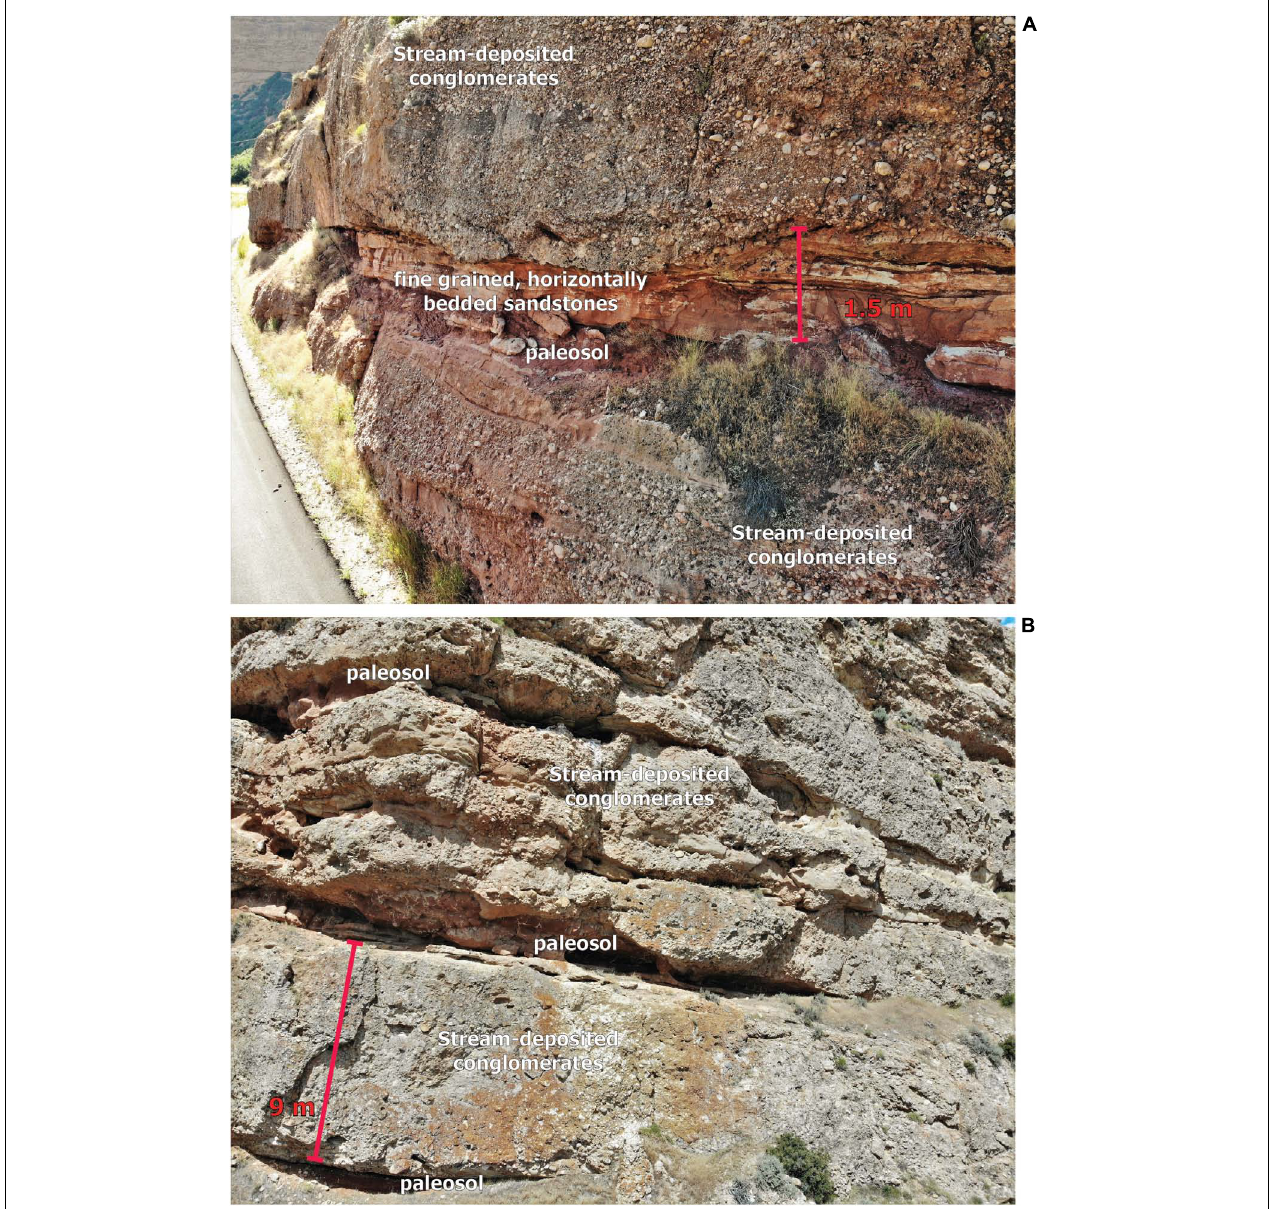
FIGURE 5 | Representative outcrops showing common facies associations in study areas. Coarse-grained conglomeratic units representing channel deposits are usually capped by paleosol horizons, which are in turn scoured into by overlying conglomerates. (A) The Echo Canyon Conglomerate. Shown in this image are clast-supported, cobble conglomerates above and below a relatively fine-grained interval containing paleosols and thin-bedded sandstones. While these conglomerates are interpreted as having been deposited by streamflow due to imbrication and trough-cross-stratification, structureless clast-supported conglomerates are quite common in the Echo Canyon Conglomerate and are interpreted as debris-flow deposits. Clast- to matrix- supported very angular conglomerates are rare (but present) and are also interpreted as deposits from debris-flows or highly concentrated flows. (B) The Richards Mountain Conglomerate. Common facies shown here are clast-supported, cobble to boulder conglomerates (interpreted as streamflow deposits) and fine-grained paleosol intervals. Notice the mottled, reddish coloration of paleosol intervals. Rhizoliths are visible in the central paleosol as light-colored lines in the red